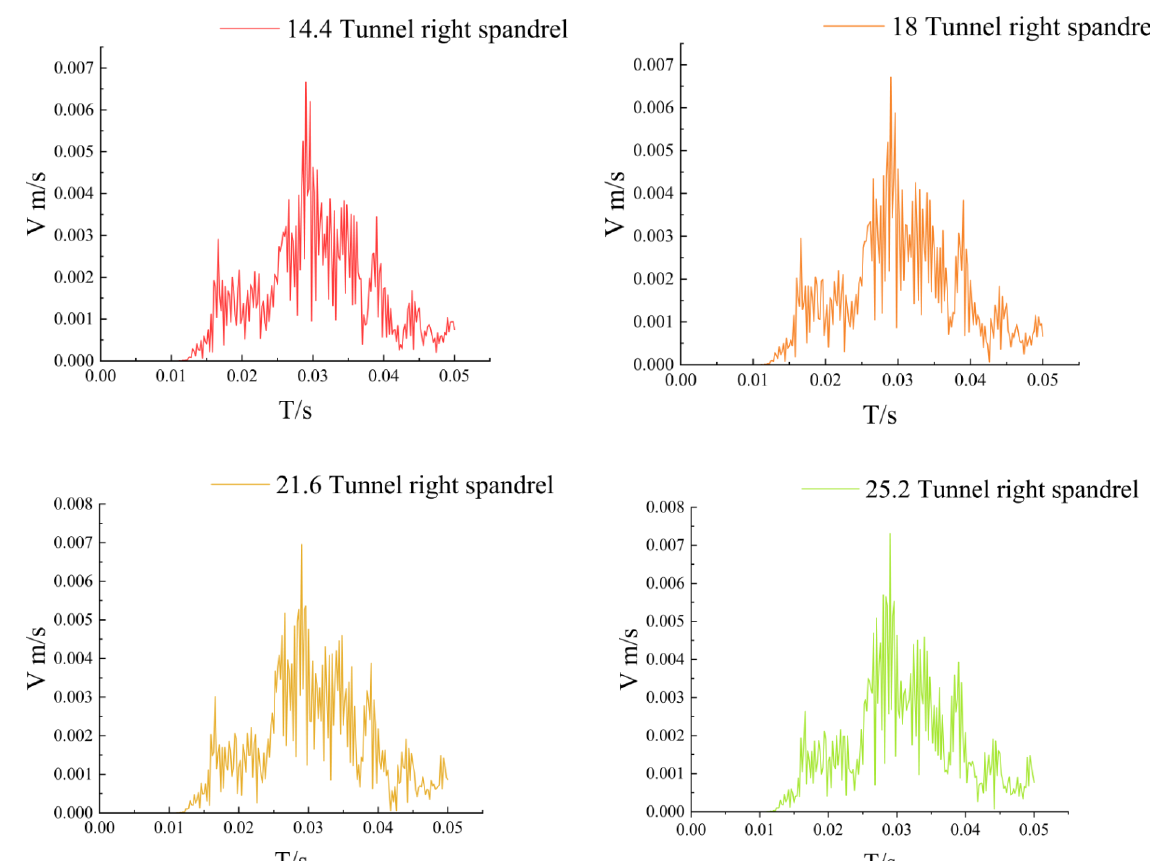
Figure 10. Steel fiber concrete tunnel right wall vibration speed curve.